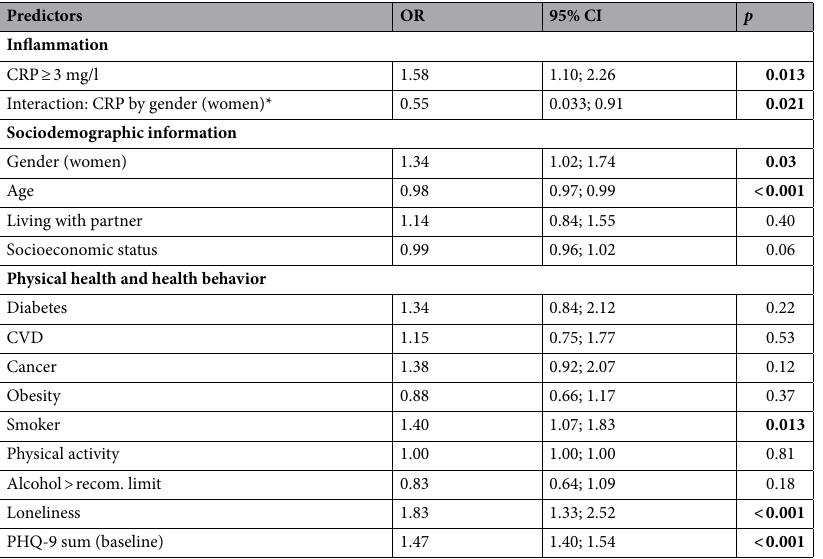
Table 2. Results of the logistic regression analysis: Prediction of new onset of depression at follow-up (based on predictors measured at baseline 5 years earlier, including CRP ≥ 3 mg/l). Bold values indicate statistically significant predictors. Total model: Nagelkerke R 2 = 0.37. CI confidence interval; CRP C-reactive protein; CVD cardiovascular disease, OR odds ratio, PHQ‑9 patient health questionnaire-9. *The odds ratio of the interaction term is a ratio of odds ratios (ROR). The OR for CRP > 3 mg/l of 1.58 is to be interpreted as the OR for men with elevated CRP. The OR for women with elevated CRP can be calculated from the ROR and the above OR for men as 1.58 × 0.55 = 0.87.